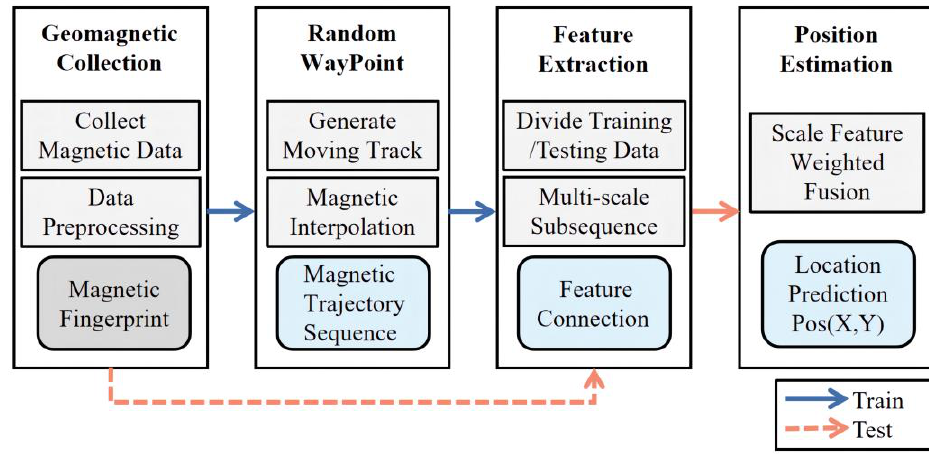
Figure 1. Schematic view of positioning system.